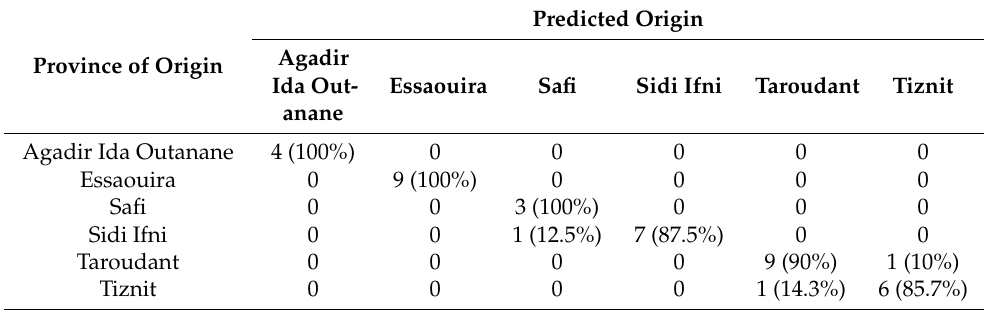
Table 4. Performance of the LDA model for prediction of origin of Argan oil from the six provinces.